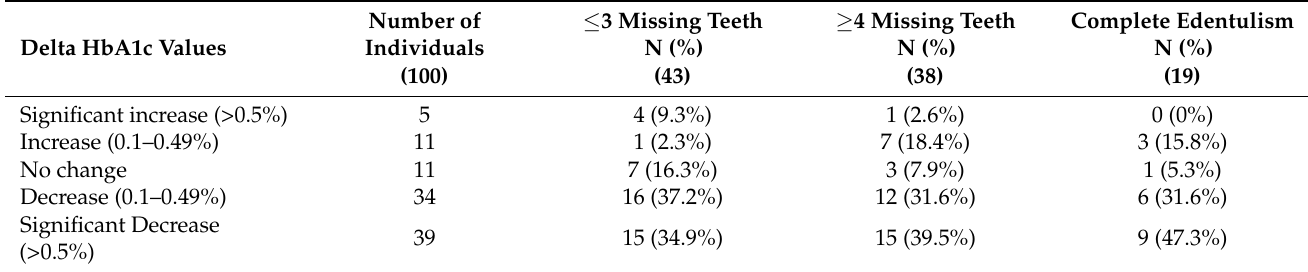
Table 7. Delta HbA1c values distribution according to jaw missing